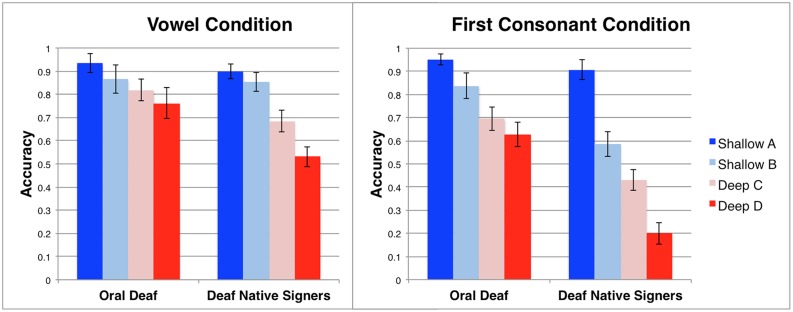
Performance on Phoneme Judgment Task (Vowels and Consonants) across groups. The orthographic transparency was manipulated in a graded manner (see Figure 1) such that orthographic information could help to accurately complete the Shallow (blue) conditions (A,B), but would be uninformative or counter-productive in the Deep (red) conditions (C,D). Error bars represent SE of the mean.